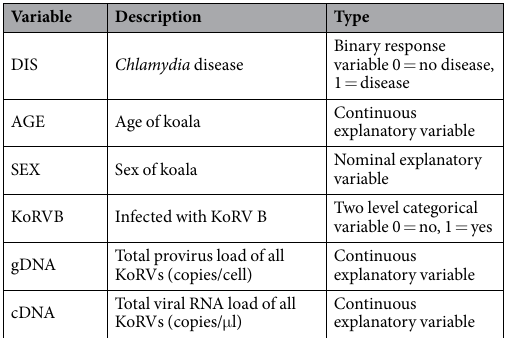
Table 2. Response and explanatory variables for modeling the relationships associated with Chlamydia pecorum disease progression in free-living koalas ( Phascolarctos cinereus ).